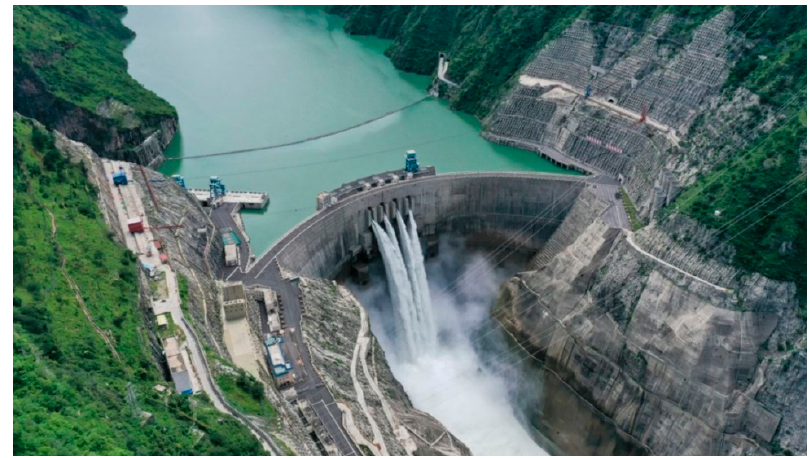
Figure 2. The concrete arch dam.